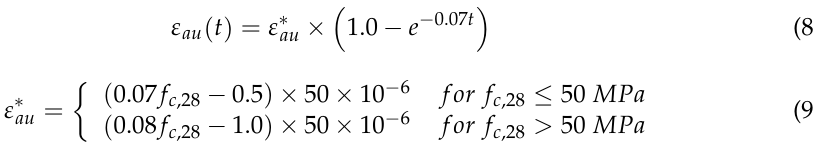
Table 4. Regression coefficients of all mixtures. Sample ID